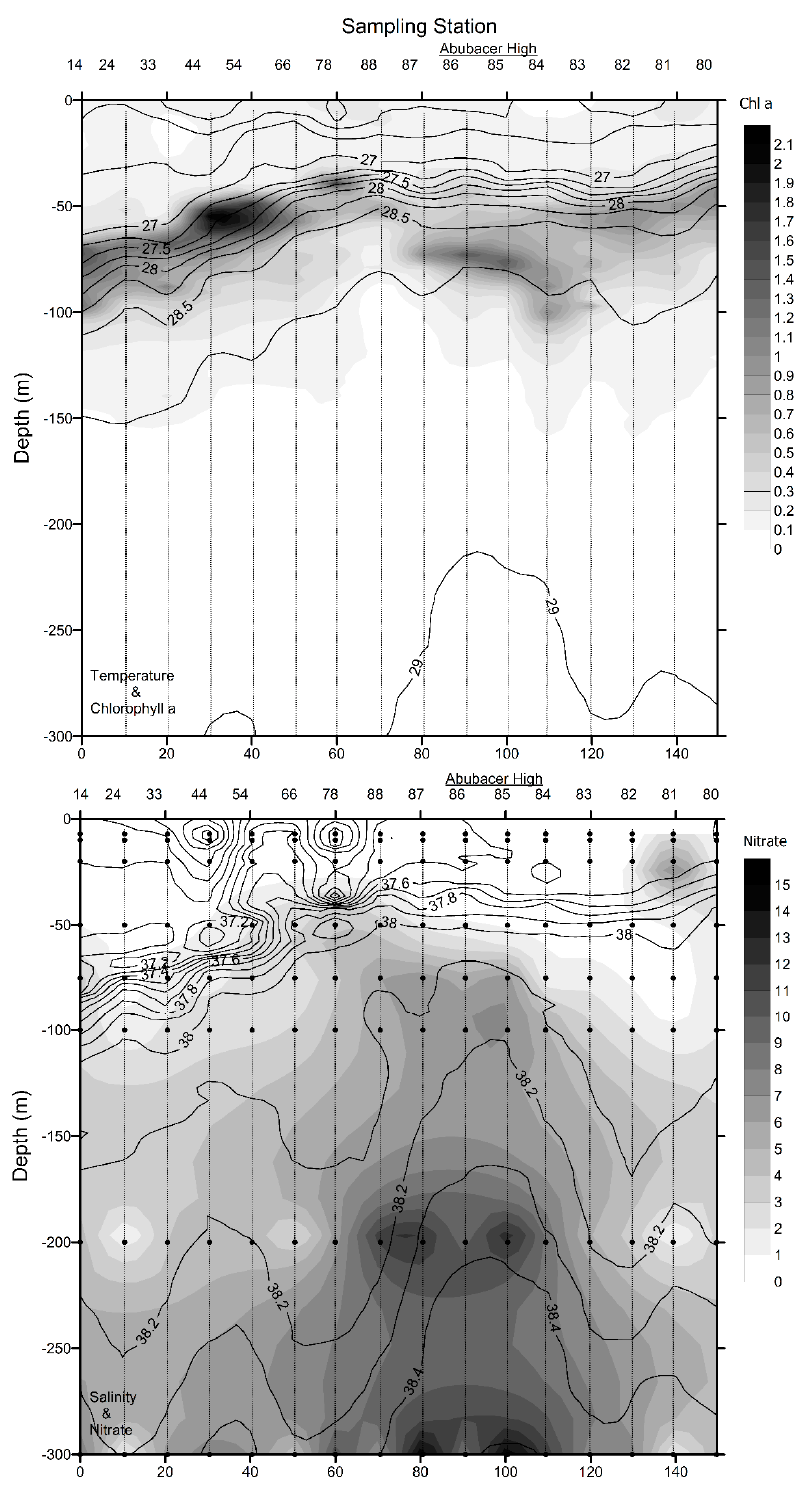
Figure 5. Offshore transect crossing the AOF (leg 1, Stn 14 to Stn 88) and the Abubacer High (leg 2, Stn 88 to Stn 80). ( a ) Temperature (°C, black labelled lines) and chlorophyll a concentration (mg ∙ m − 3 , greyscale); ( b ) salinity (black labelled lines) and nitrate concentration ( μ M, greyscale).